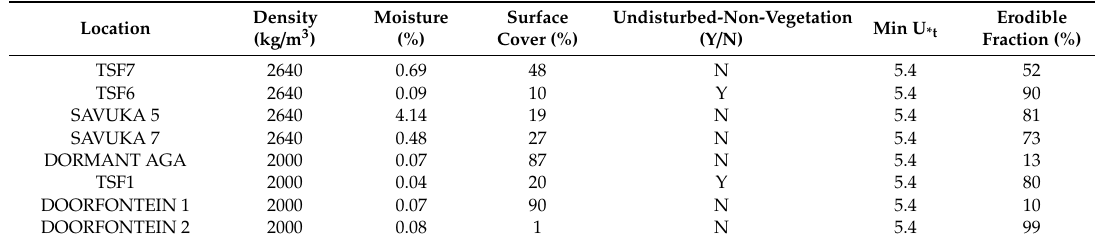
Table 1. ADDAS model key inputs for dispersion modelling, moisture content and surface cover. Location